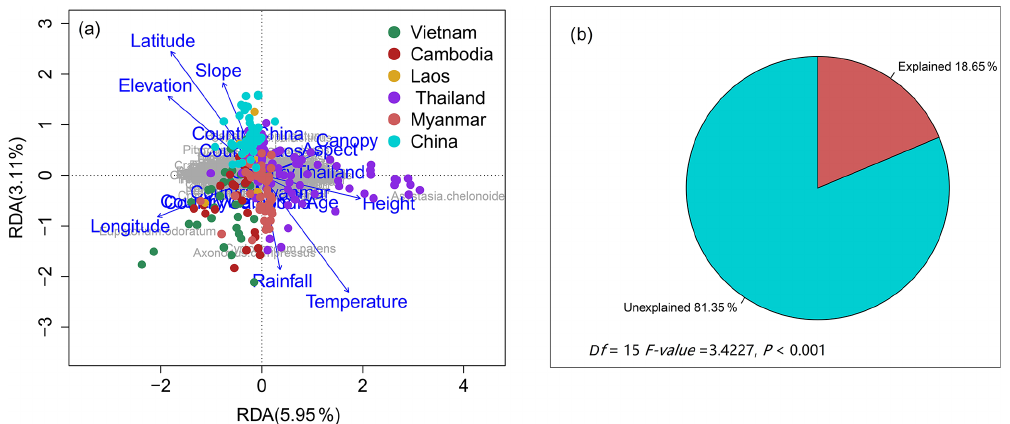
Figure 4. Redundancy analysis of plant community compositions of rubber plantations in the GMS ( a : RDA ordination; b : percentage of explained and unexplained by RDA